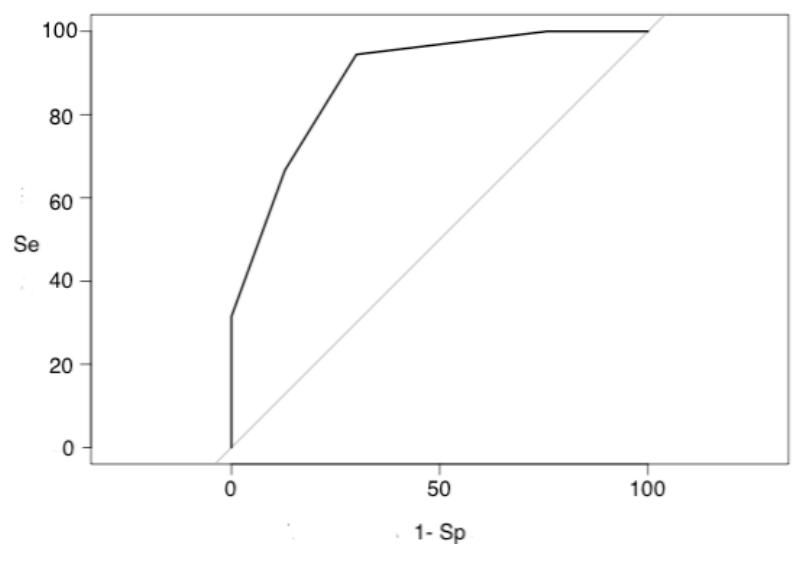
Figure 2. ROC curve ZFS. Table 8. ROC curve interpretation thresholds. Table 8. ROC curve interpretation